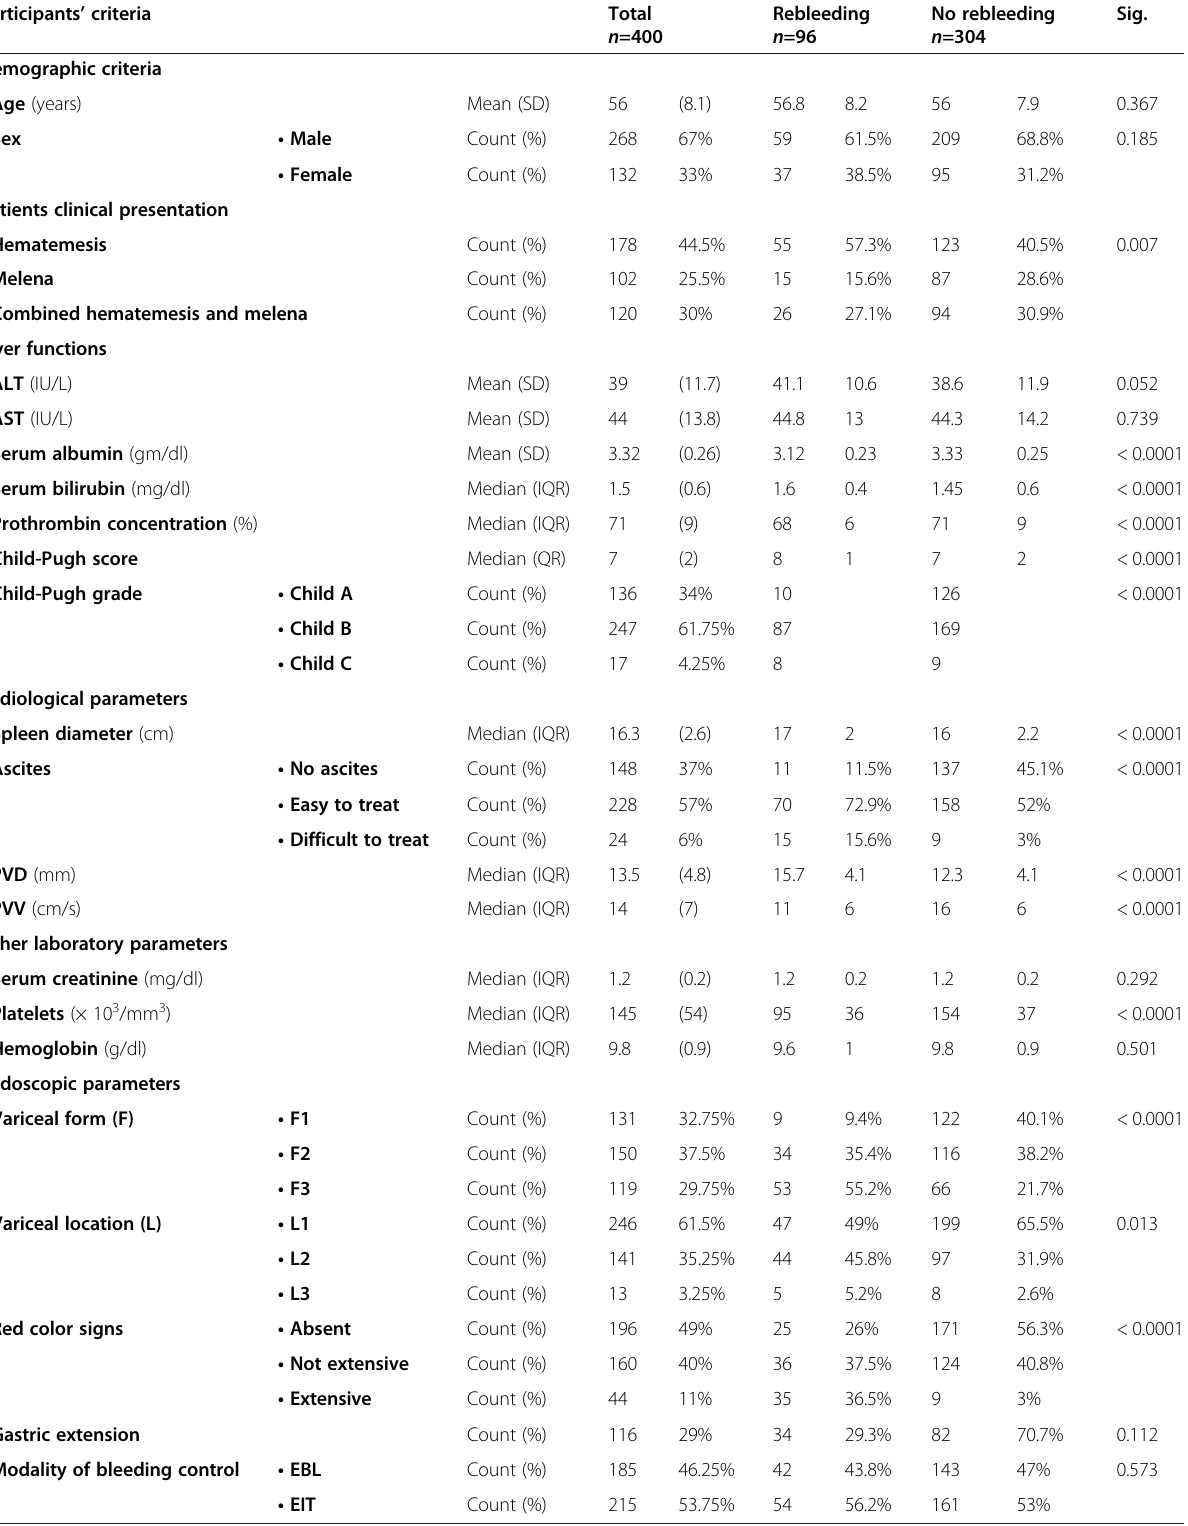
Table 1 Main evaluated participants ’ criteria Participants ’